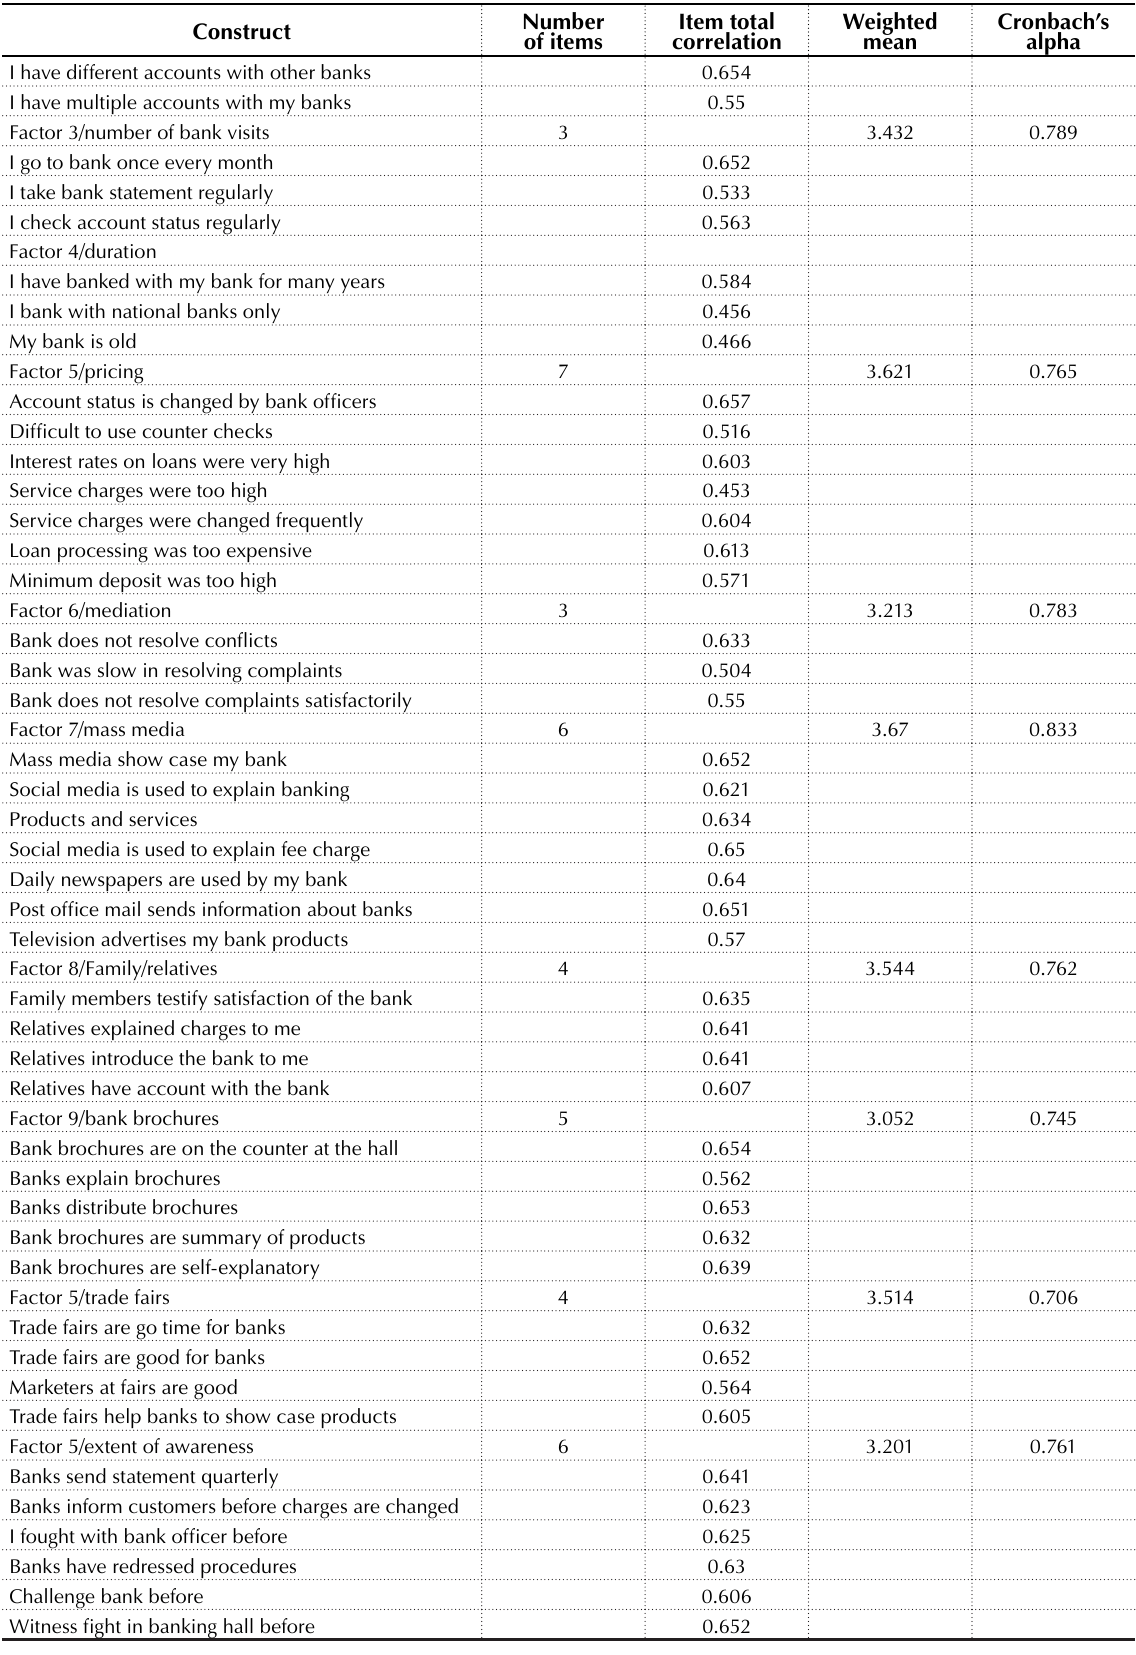
Table 2 (cont.). Internal consistency of